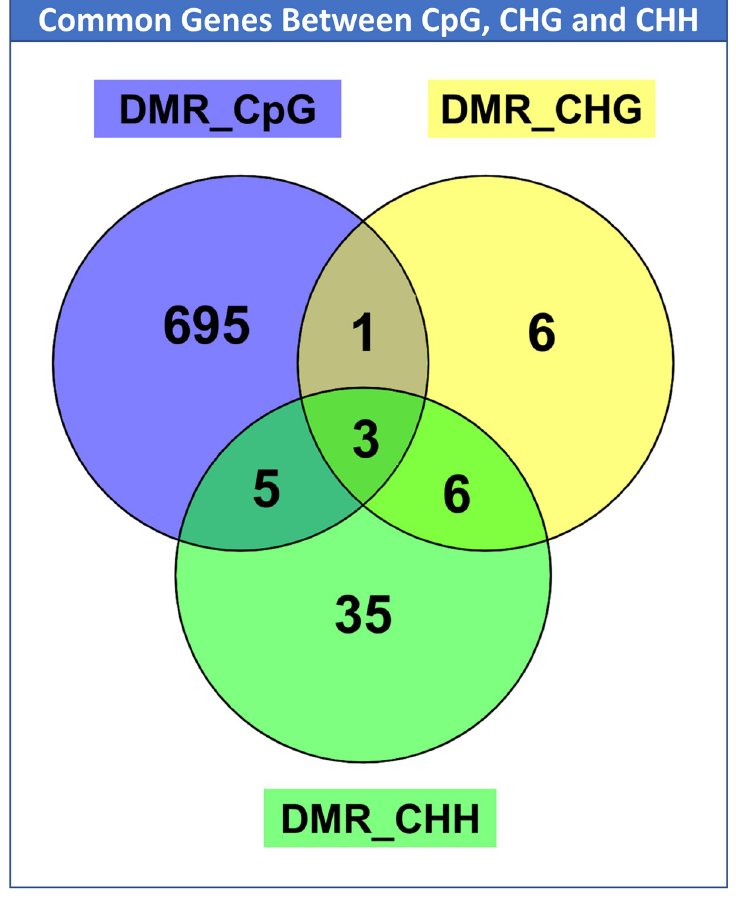
Fig 6. DMR genes common between the three contexts. DMR genes common between the three contexts. Venn diagram depicting the genes that are shared among CHH (green), CpG(purple) and CHG (yellow), in the DMC context. There are three genes in common among the 3 contexts, one in common between CpG and CHG, five in common between CpG and CHH, and six in common between CHG and CHH.